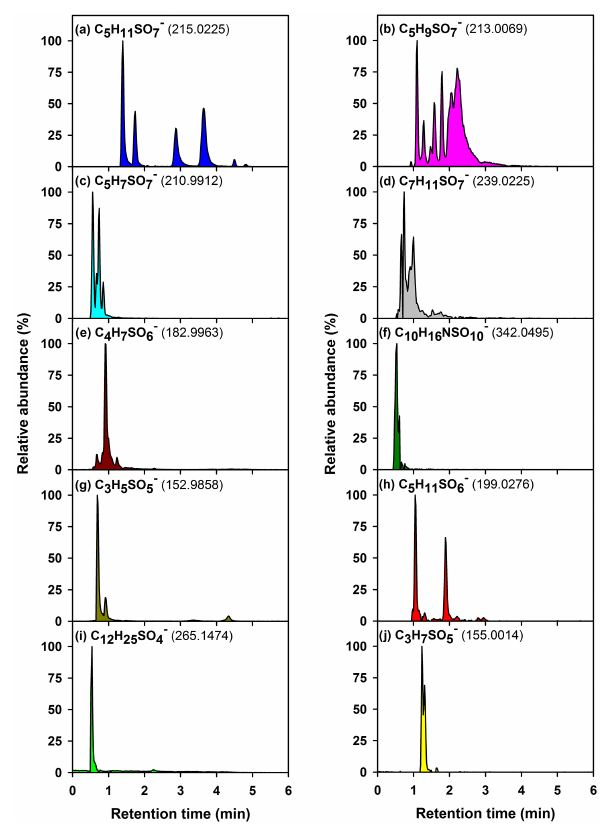
Figure 3. Extracted chromatograms for the 10 major organosulfates (monoisotopic mass ± 0.01 Da) in the daytime sample collected on 10 July 2013 using